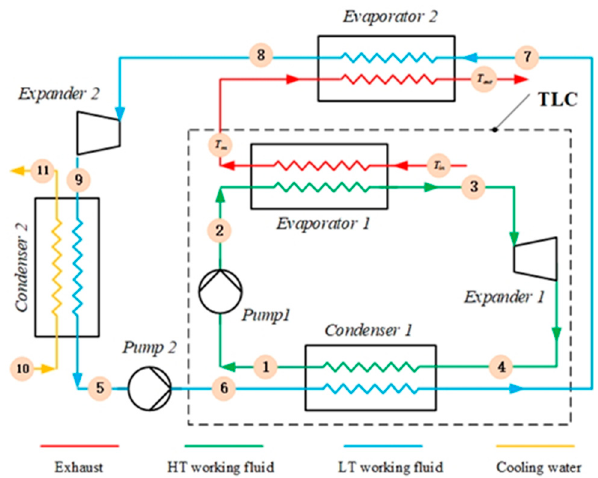
Figure 1. Schematic diagram of the TLC-ORC waste heat recovery system.